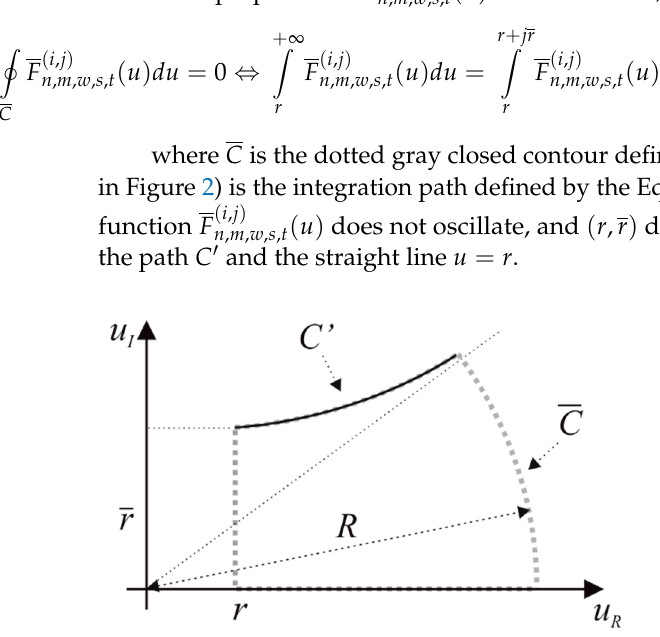
Figure 2. Integration